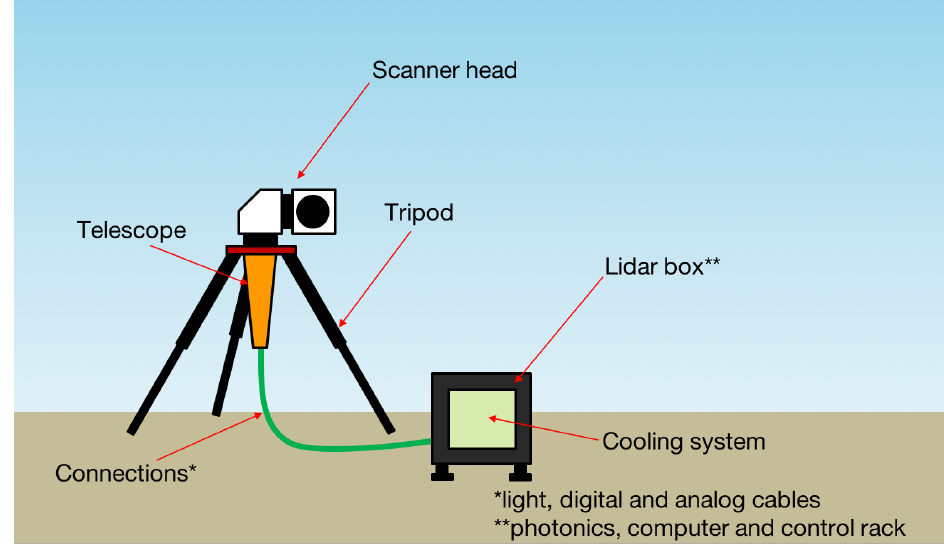
Figure 4. A concept of a modular scanning lidar (courtesy of DTU Wind